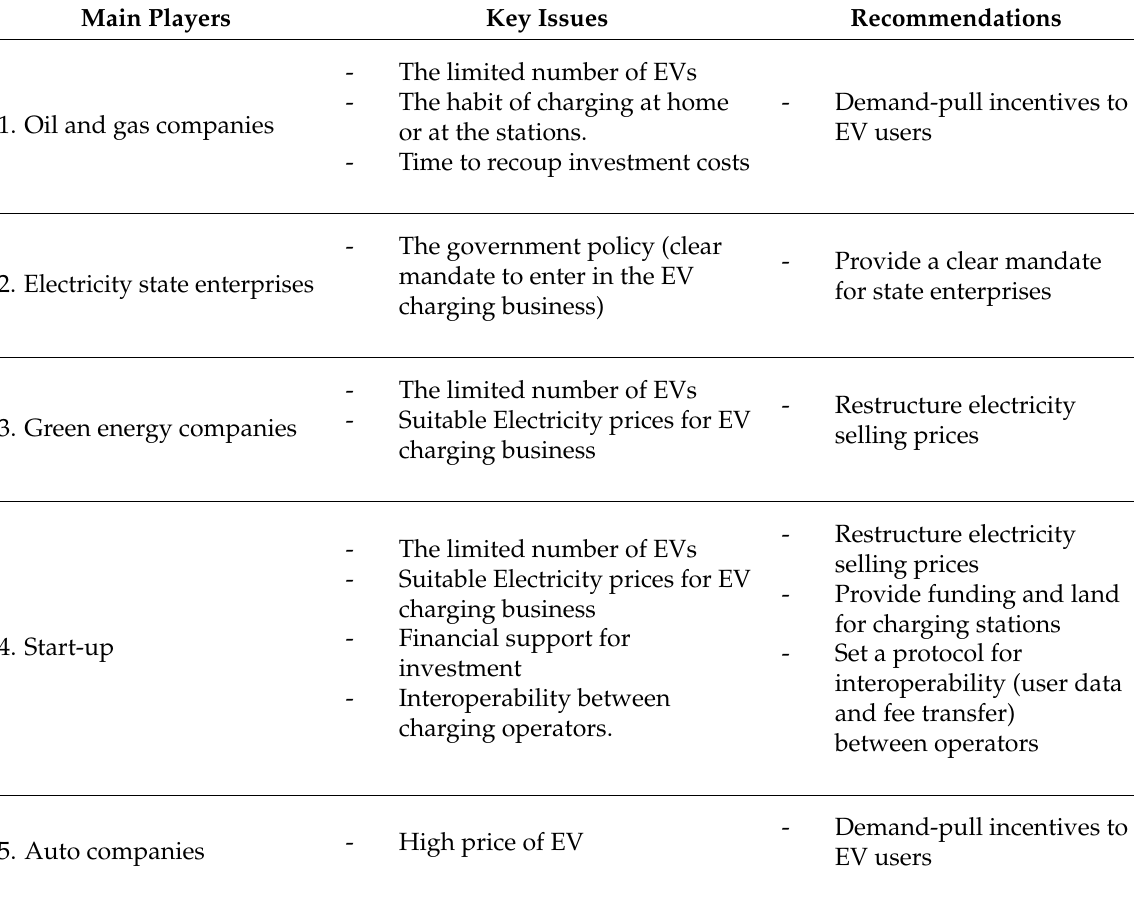
Table 11. Key issues and recommendations for the development of EV charging